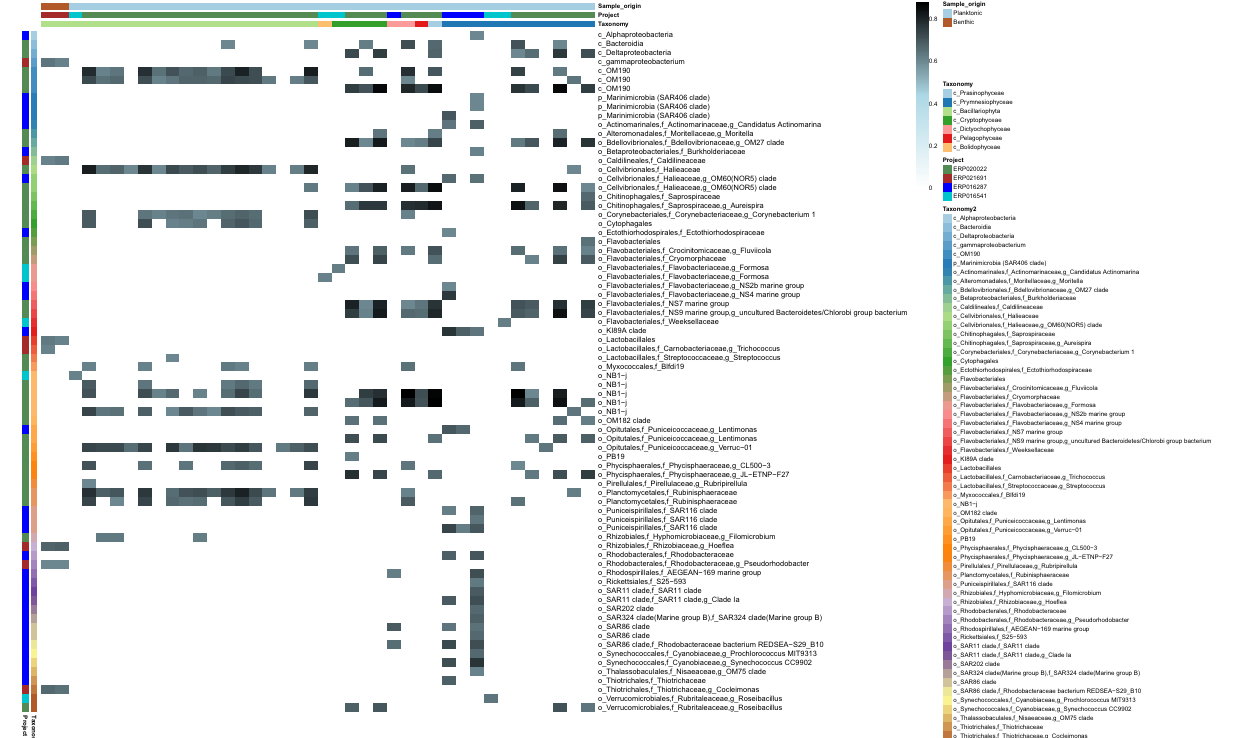
Figure 1. Summarised interactions in marine environments. Correlation heatmap of co-occurring microalgae (columns) and bacteria (rows) in marine environments. “Taxonomy” represents the taxonomic affiliations of microalgal nodes at class level. “Taxonomy2” represents the taxonomic affiliations of bacteria (p_, c_, o_, f_ and g_ represent Phylum, Class, Order, Family and Genus, respectively). “Project” represents the accession numbers of EMP projects and indicate which project the microalgal and bacterial nodes were recovered from. “Sample_origin” indicates if each sample is planktonic or benthic. Heatmap colour gradient indicates correlation coefficients. Refer Table S2 for raw data used to generate the heatmap. Heatmap was generated using Pheatmap v1.0.12 (https:// rdrr. io/ cran/ pheat